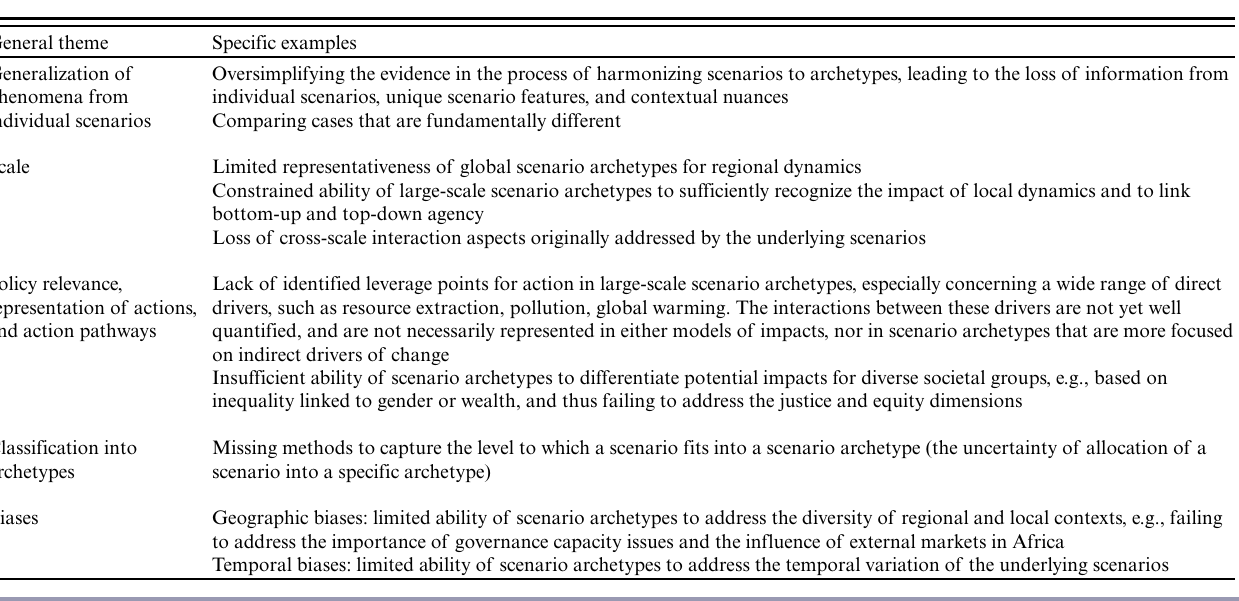
Table 3 . Summary of challenges of the scenario archetype approach, identified by a survey among Intergovernmental Science-Policy Platform for Biodiversity and Ecosystem Services (IPBES)